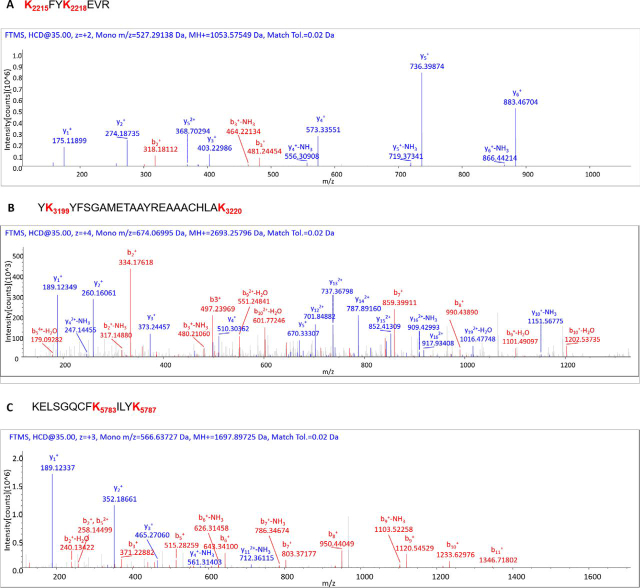
MS2 spectrum of synthetic acetylated peptides. MS/MS Spectra of synthetic acetyl-lysine containing peptides. A, K2215FYK2218EVR; B, YK3199YFSGAMETAAYREAAACHLAK3220; C, KELSGQCFK5783ILYK5787.